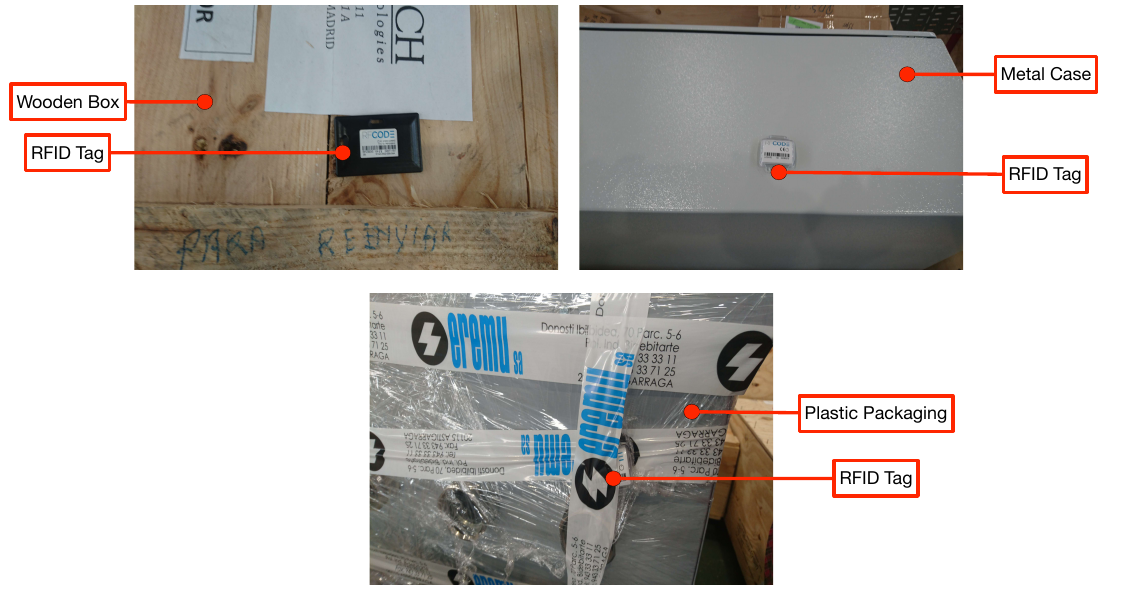
Figure 8. Warehouse material